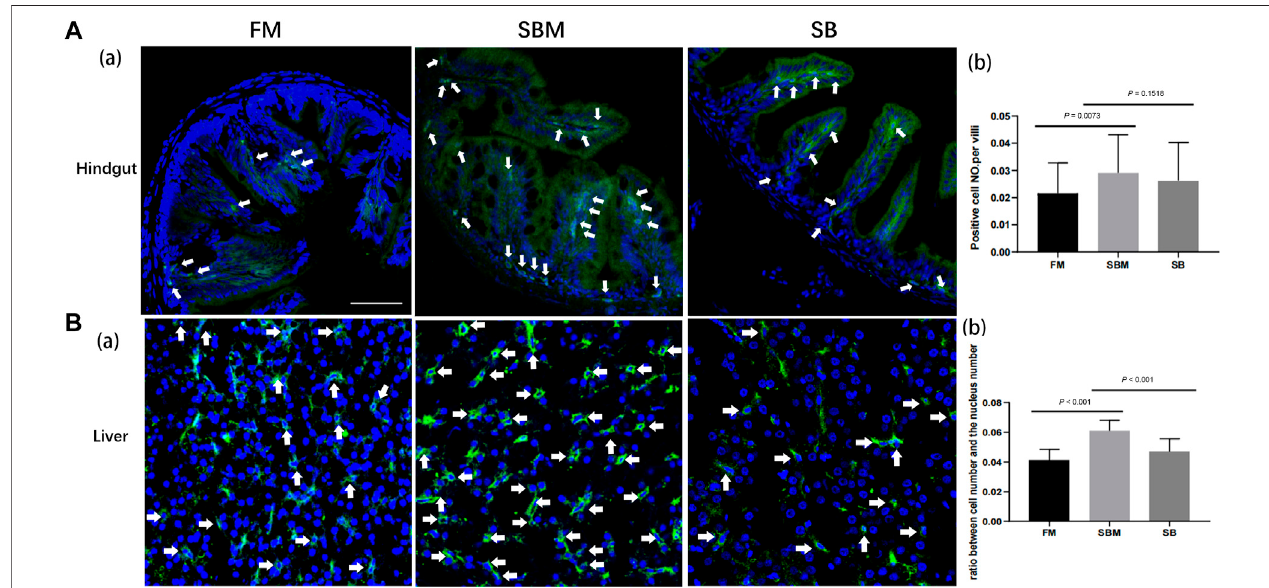
FIGURE2| TheeffectofseabuckthornonintestinalandhepaticThelpercellsre fl ectedbyimmunohistochemistrysignals. (A) Therepresentativeimages (a) andthe bar diagram for quantitative analysis (b) of intestinal CD4 labeled Th cell signals as well as the quantitative analysis of signals in FM, SBM and SB groups; (B) The representativeimages (a) andthebardiagramforquantitative analysis (b) ofhepatic CD4labeled Thcellsignalsaswellasthequantitative analysisofsignalsinFM,SBM and SB groups. The typical signals were indicated by arrows. Scale bar: 100 μ m.